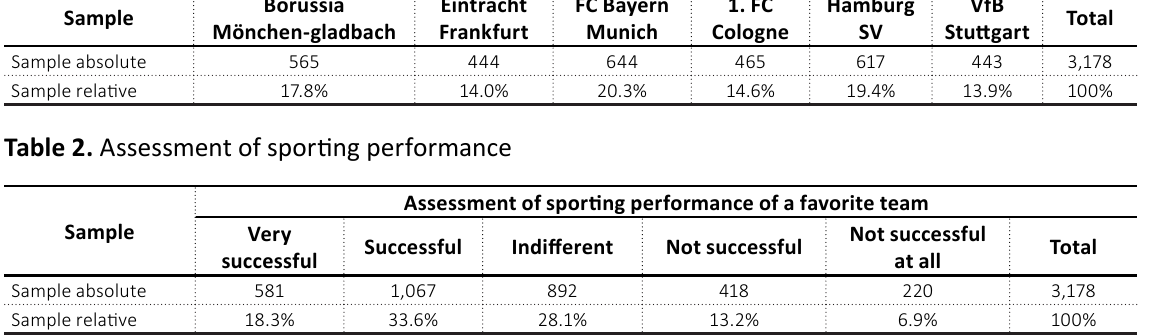
Table 1. Composition of the sample Sample